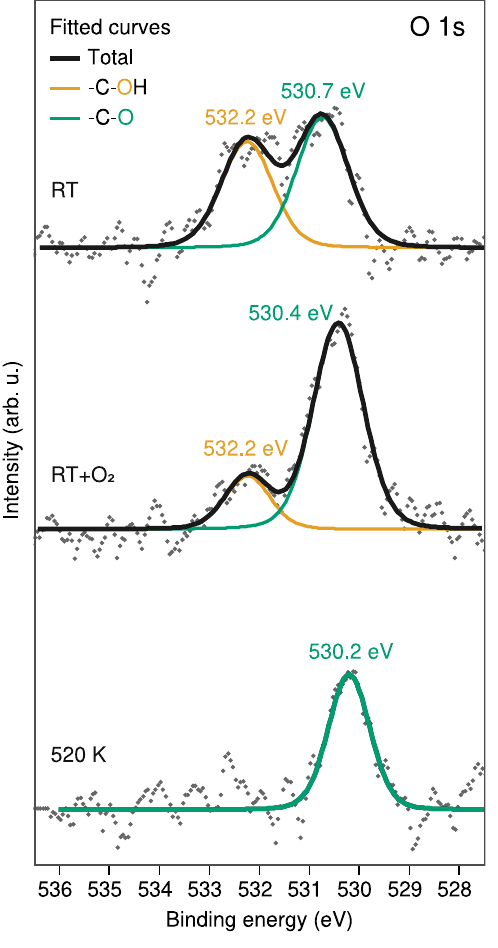
Fig. 5 | XPS of the EHBP O 1s core level at different reaction stages after deposition on clean Ag(100). The O 1s signature for the arrays formed at RT displaytwopeaksat532.2and530.7eVwithalmostequalintensities,indicatingthe partial dehydrogenation of hydroxyl entities. The peak at 532.2eV vanishes after annealing the substrate at 520K, revealing fully dehydrogenated hydroxyl end- groups. Gray dots in the plots denote the linear-background-subtracted XPS data, andallpeakswere fi ttedusingaLorentzianlineshape,LA(1.53,243).Sourcedataare provided as a Source data fi